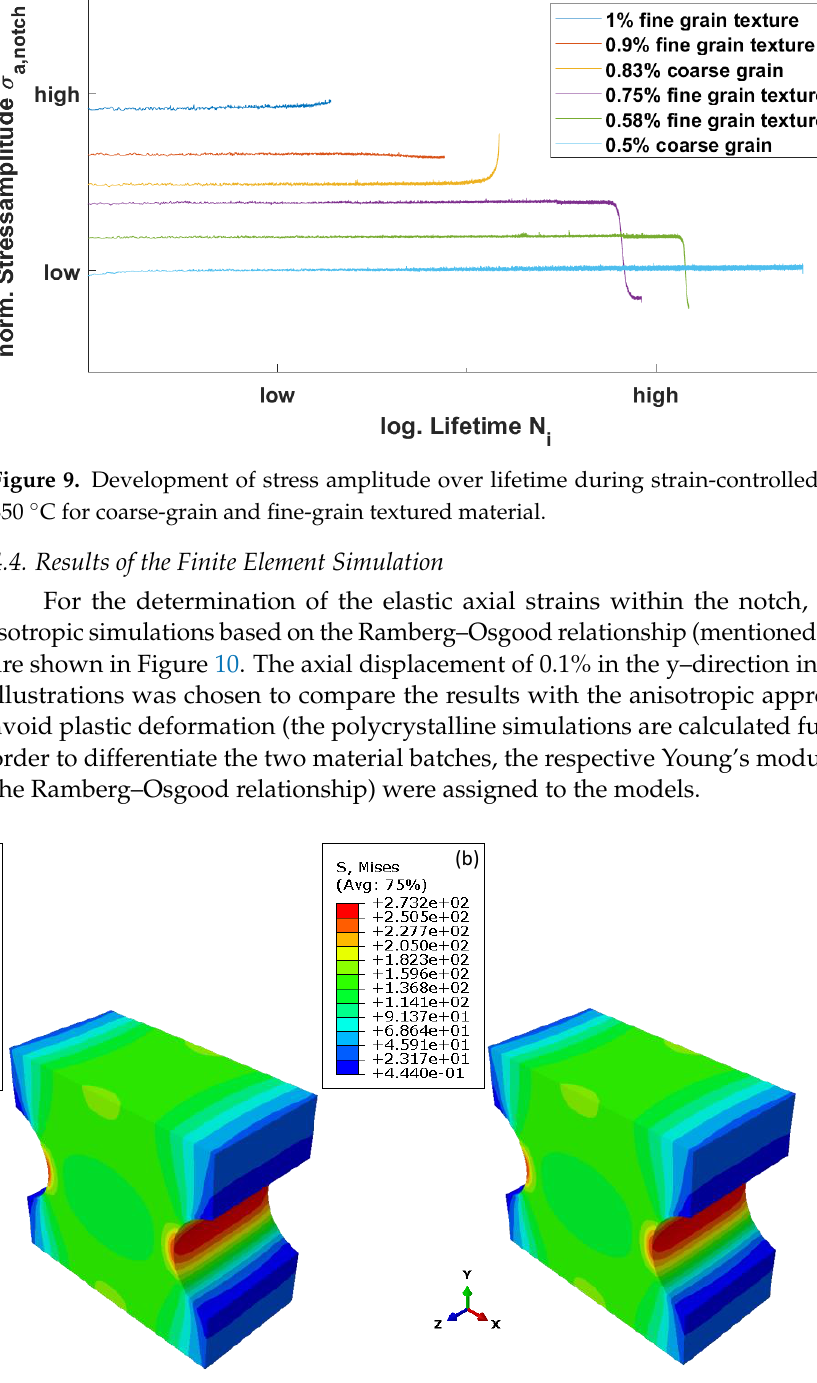
(b) Figure 11. Distribution of von Mises stress for notched specimen for the coarse-grain material (100 grains, ( a )) and fine- grained textured material (1000 grains, ( b )). It can be clearly seen that compared to an isotropic approach the stress distribution is highly inhomogeneous within the notch area, as well as in the bulk material caused by